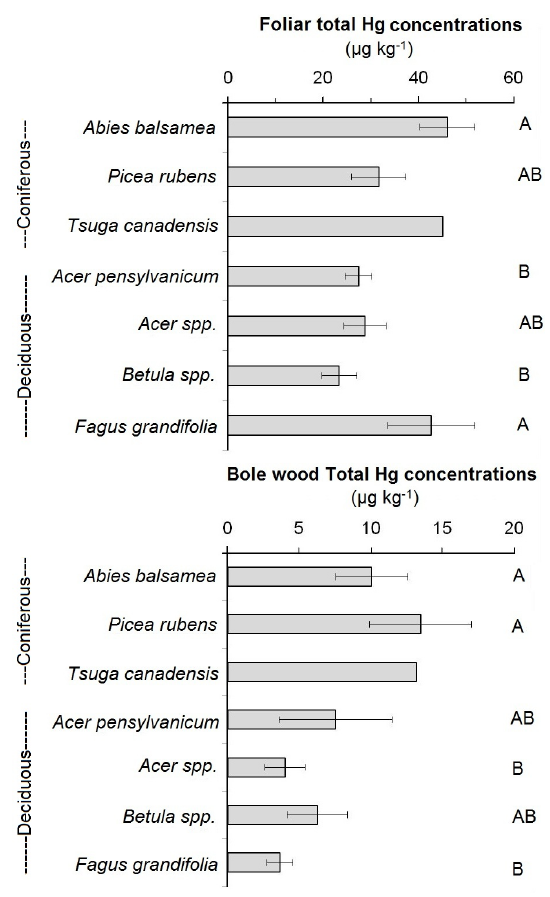
Figure 4. Total Hg concentrations in dry weight leaves and wood from 2012, 2013, and 2014 forest stand samplings. Mean values are given ± 1 standard error. Letters (A, B) indicate a significant difference using the Kruskal–Wallis test with post hoc Wilcoxon rank-sum test ( P <0.05). Each species/genus ( n = 8), except Tsuga canadensis ( n = 1), which was not included in statistical